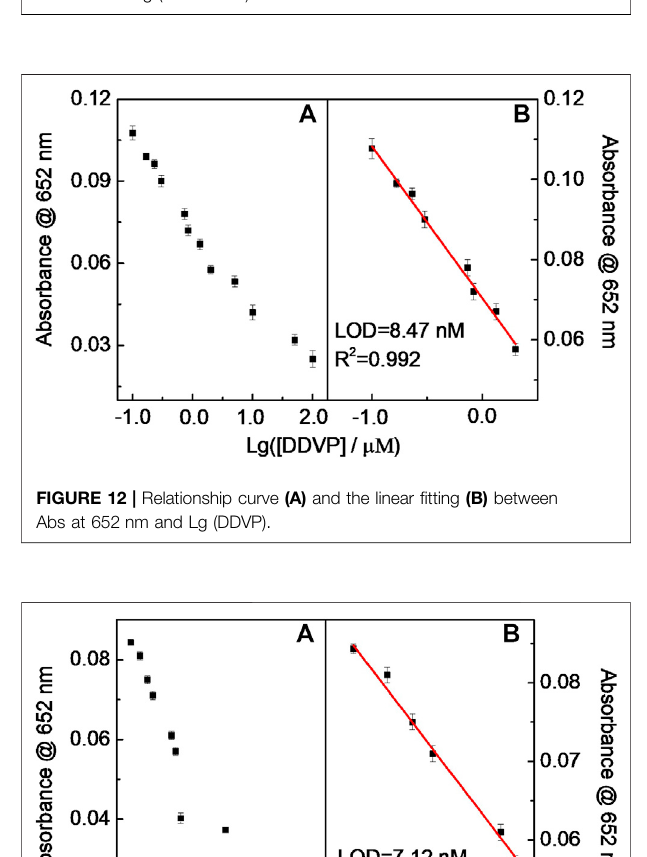
Frontiers in Chemistry |